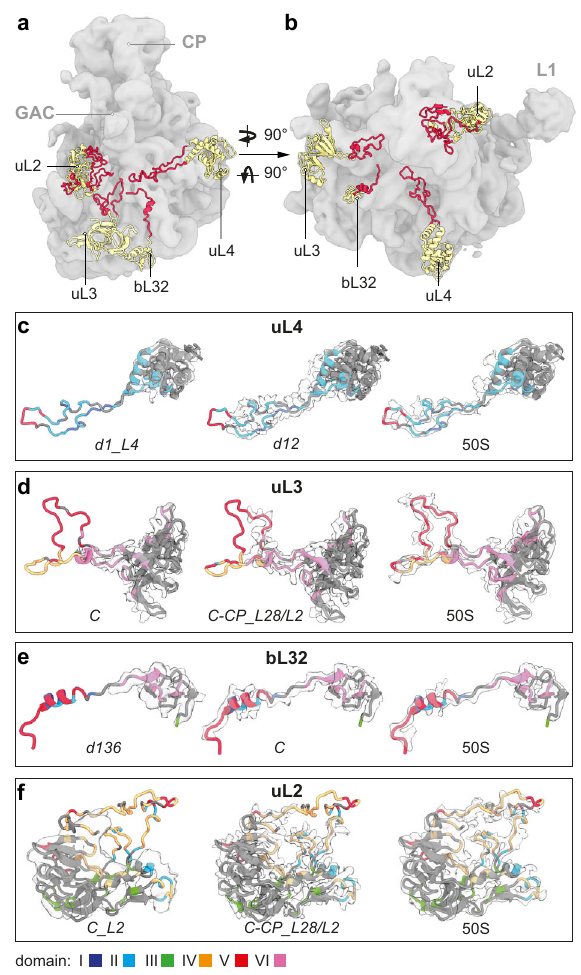
Fig. 4 |L-proteinswithextensions.a Sideview, b topview of alowpass- fi ltered C- CP-H68 cryo-EM map (gray) with models of selected L-proteins exhibiting globular domains (yellow) and extensions (red). CP, central protuberance; GAC, GTPase associatedcenter;L1,L1stalk. c – f Cryo-EMmaps(lightgray)ofselectedL-proteins, derivedfromtheindicatedstates,andcorrespondingatomicmodels(EMD-22614). Protein models are colored according to their rRNA domain contacts; gray color indicates self-interaction, or surface exposure ( “ Methods ”